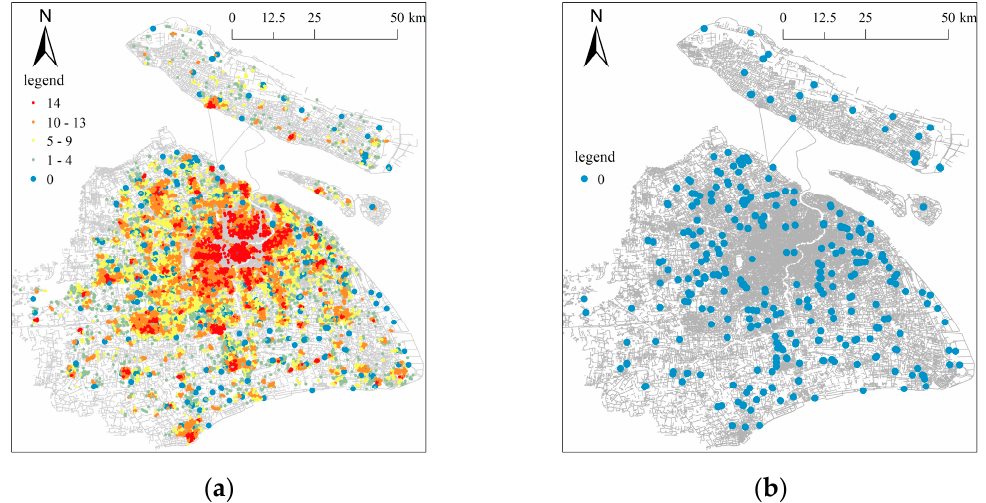
Figure 4. The number of types of attainment facilities in each community within the 15 ‐ min life circle. ( a ) The number of types of attainment facilities in all communities; ( b ) The communities with 0 types of attainment facilities.